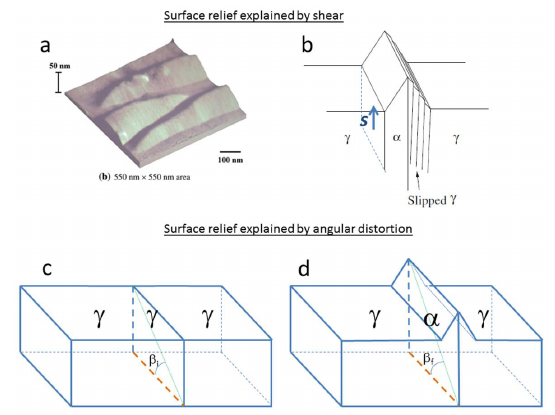
Figure 25. Interpretation of the surface relief formed by an fcc-bcc transformation. ( a ) Image made by atomic force microscopy of bainite plates, and ( b ) their interpretation by a shear mechanism. Reprinted from [128] with permission from Springer Nature. ( c , d ) Alternative explanation with an angular distortive mechanism. Surface ( c ) before transformation, and ( d ) after transformation; the tent-shape is compatible with an intra-planar distortion of the habit plane (without rotation).